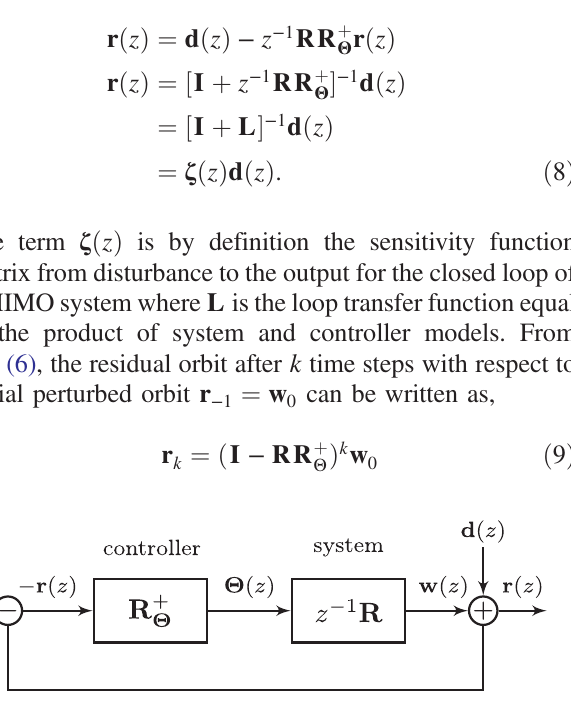
FIG. 2. Schematic of the digital closed orbit feedback system in the slow regime. − r ð z Þ is the error signal, Θ ð z Þ is the corrector settings, r ð z Þ is the residual orbit, and d ð z Þ is the disturbance defined in Eqs. (7) to